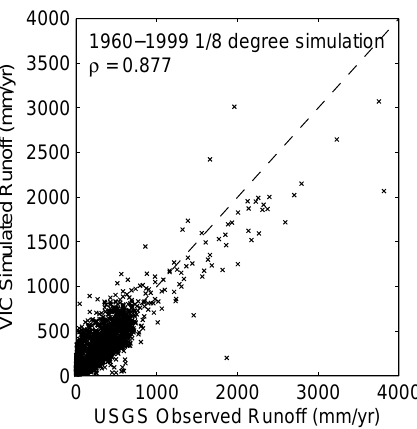
Fig. 10. The 1960–1999 USGS WaterWatch observed runoff ver- sus the VIC simulated annual total runoff (surface runoff + base flow) for each HUC8 subbasin using the Ashfaq et al. (2010) 1/8 ◦ ( ∼ 12km) resolution data